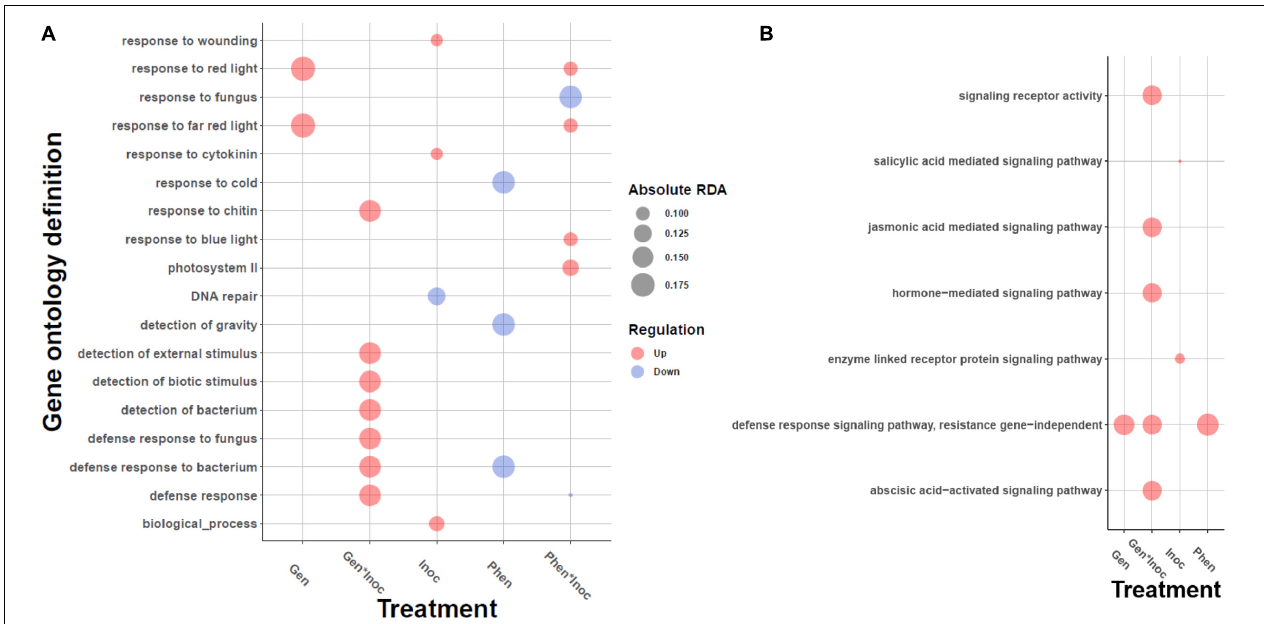
FIGURE 4 | Gene ontology enrichments of the genes contributing to the redundancy analysis (RDA) axes for treatment, genotype and phenotype levels. Enrichment test was carried out using gene loadings along RDA axes, see “Materials and Methods” section. The bubble plot depicts (A) biotic and abiotic responses, and (B) enrichment limited to signaling hierarchies. The size of the bubble is proportional to the mean fold change of the genes assigned to the GO category and the color describes the direction, upregulation (red) or downregulation (blue).